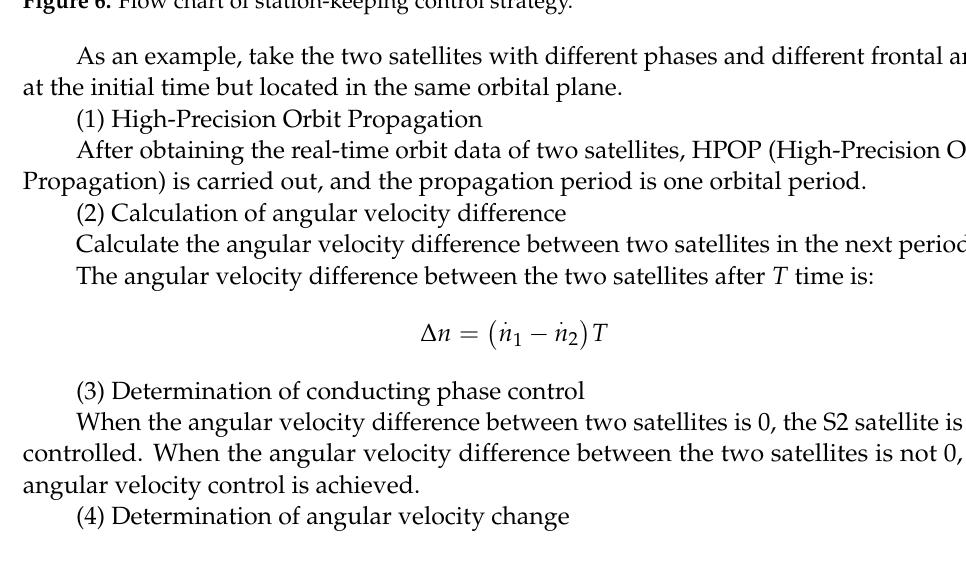
Figure 6. Flow chart of station-keeping control